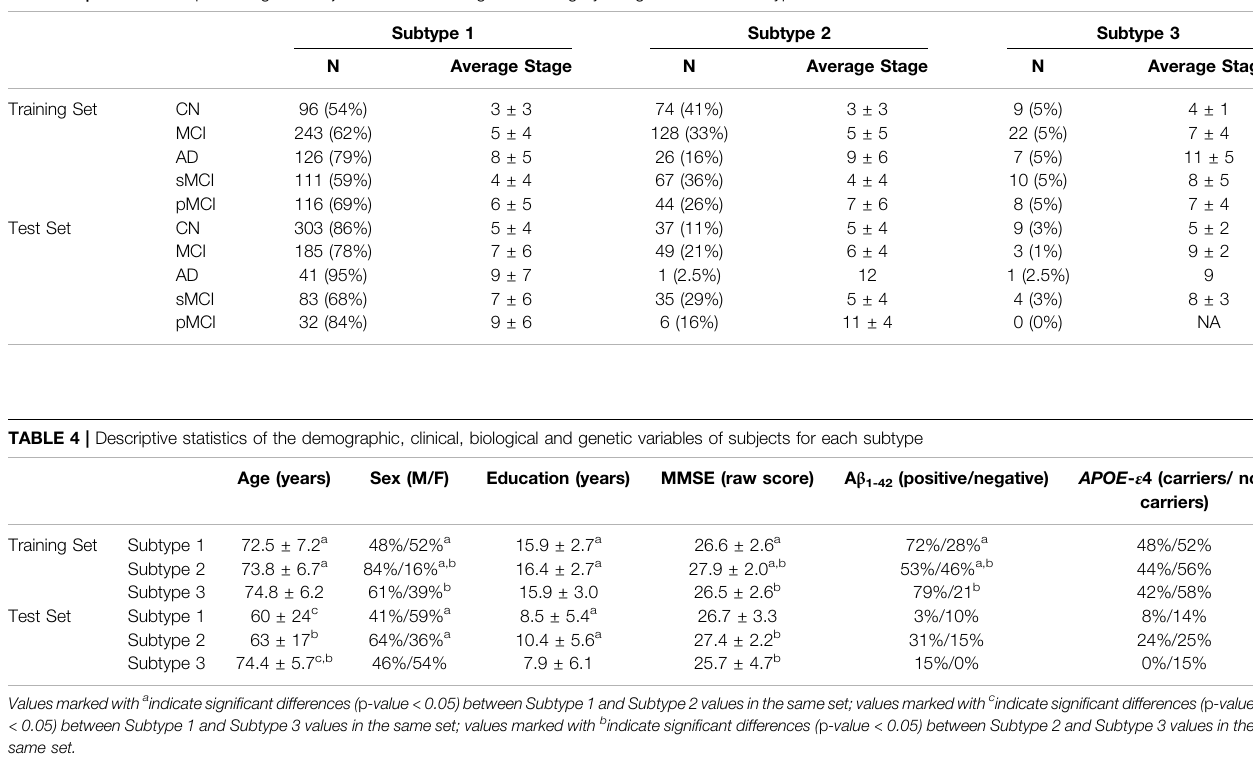
Frontiers in Big Data |